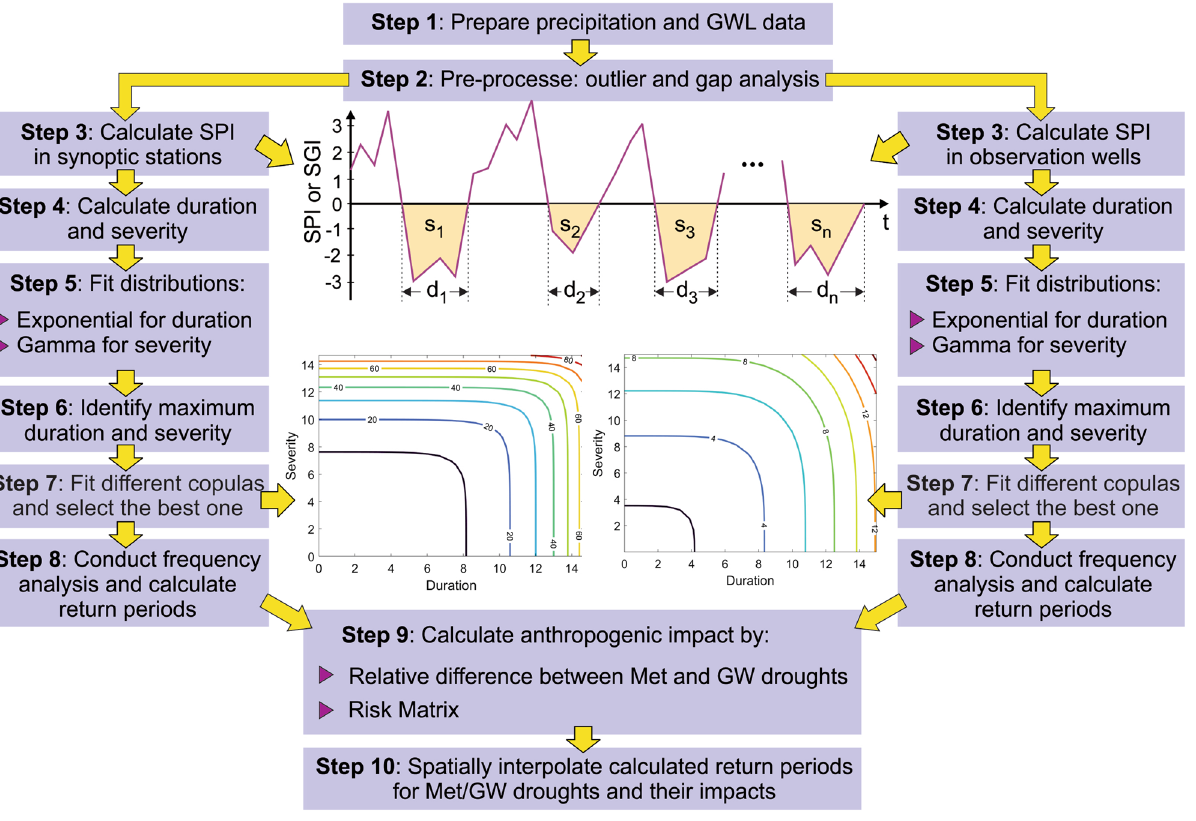
Figure 1. Modelling strategy and definition of drought duration (d) and severity